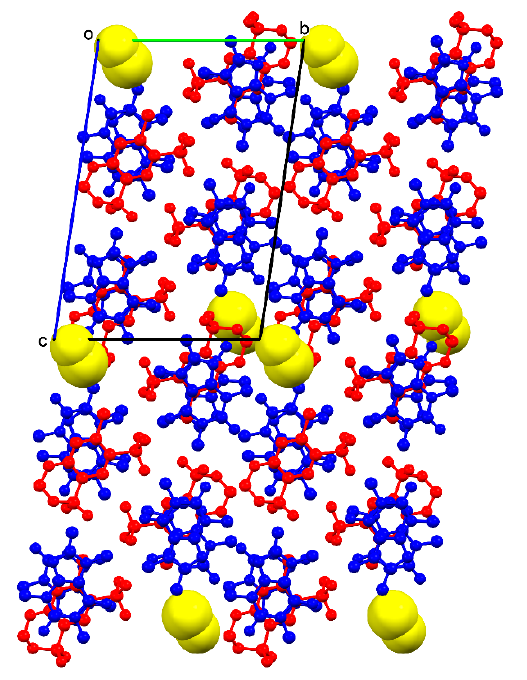
Figure 6. Projection of the crystal packing of HCT-CAF · MET ( bc -plane). Components are color-coded: HCT (red), CAF (blue), MET (yellow).